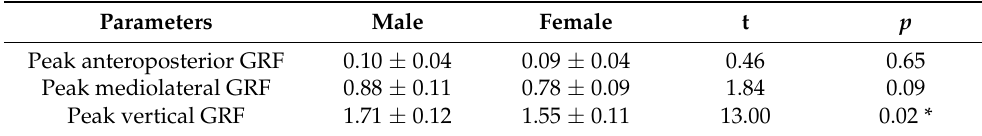
Table 2. GRF of male and female athletes (unit: %BW). Parameters